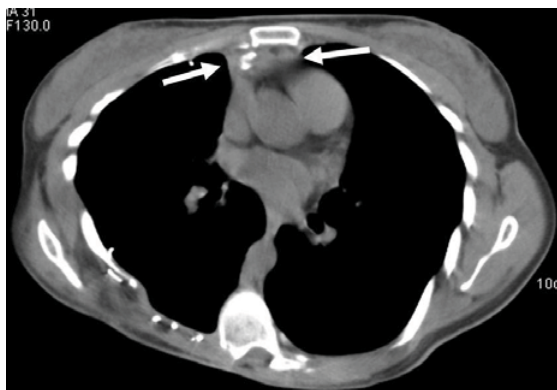
Figure 3. Axial thorax CT image shows osteosarcoma metastases with calcific foci in the anterior mediastinal space